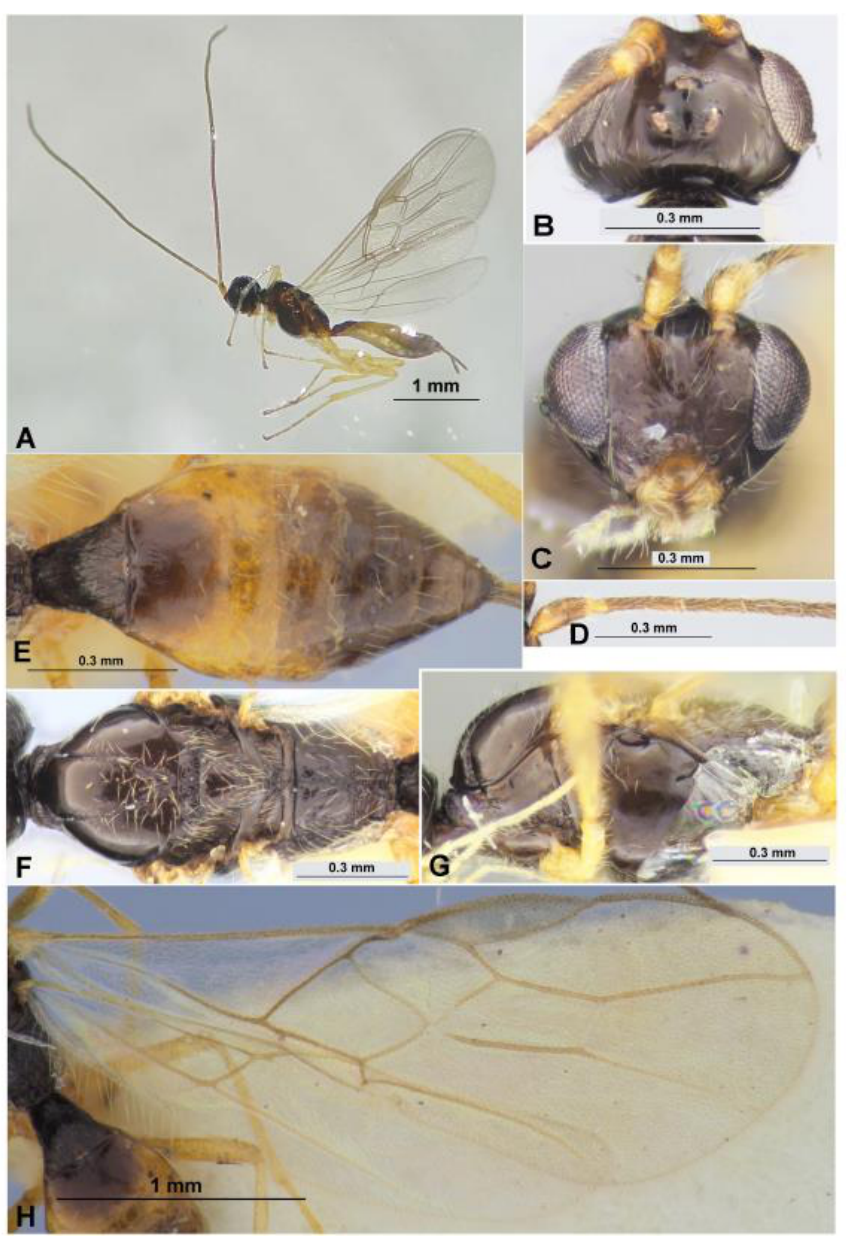
Figure 14. Exothecinae: Colastes braconius (Haliday, 1833) (female). Habitus in lateral view ( A ), head in dorsal ( B ) and frontal ( C ) views, basal segments of antenna ( D ), metasoma in dorsal view ( E ), mesosoma in dorsal ( F ) and lateral ( G ) views, fore and hind wings ( H ). Material examined. One female, Novosibirsk Province, Central Siberian botanical garden, from Ph. issikii mine on Tilia platyphyllos , 26.VI.2020 (leaf mine coll.), 8.VII.2020 (par. em.), N. Kirichenko coll. “Tp -P-4-1, DNA barcoded: sample ID NK-20-30, process ID GPRU030- 21”.